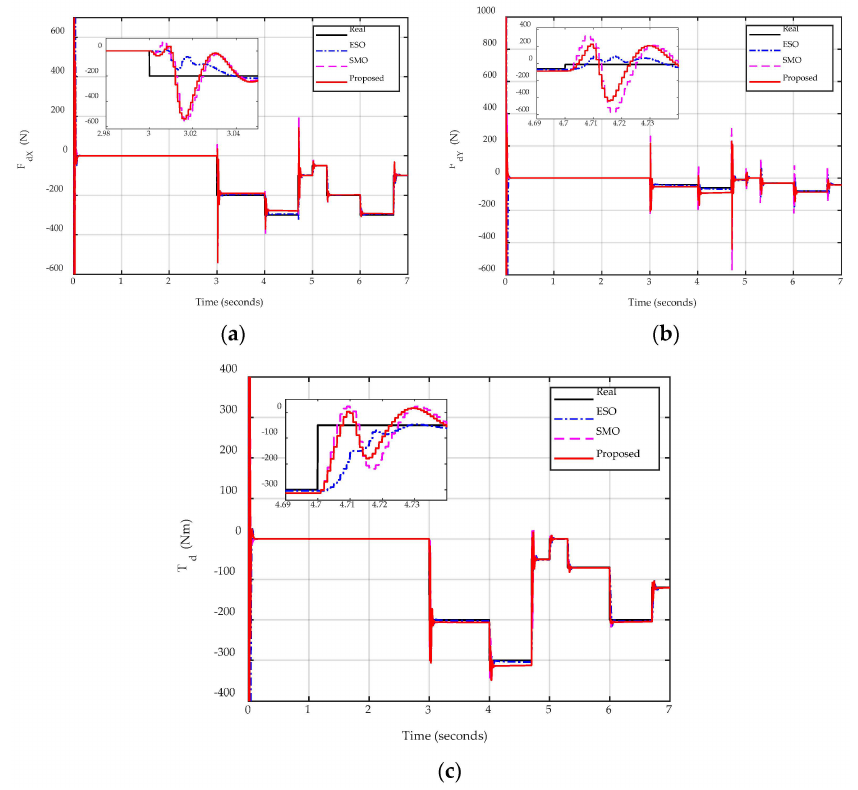
Figure 10. Estimation performance of ( a ) force disturbance in the x-direction, ( b ) force disturbance in the y-direction, and ( c ) torque disturbance in Case